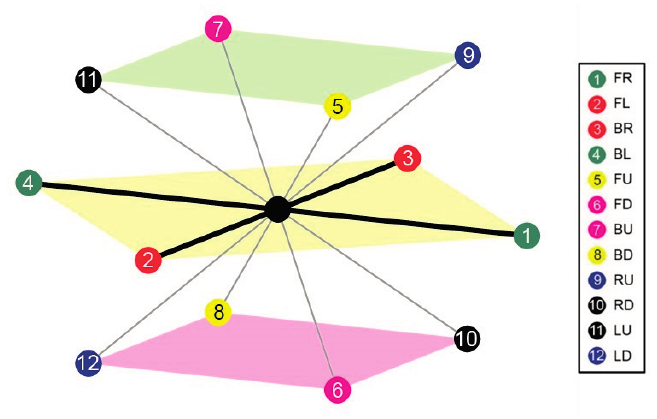
Figure 3. The FCC lattice model: Each lattice point has 12 neighbours schematic.